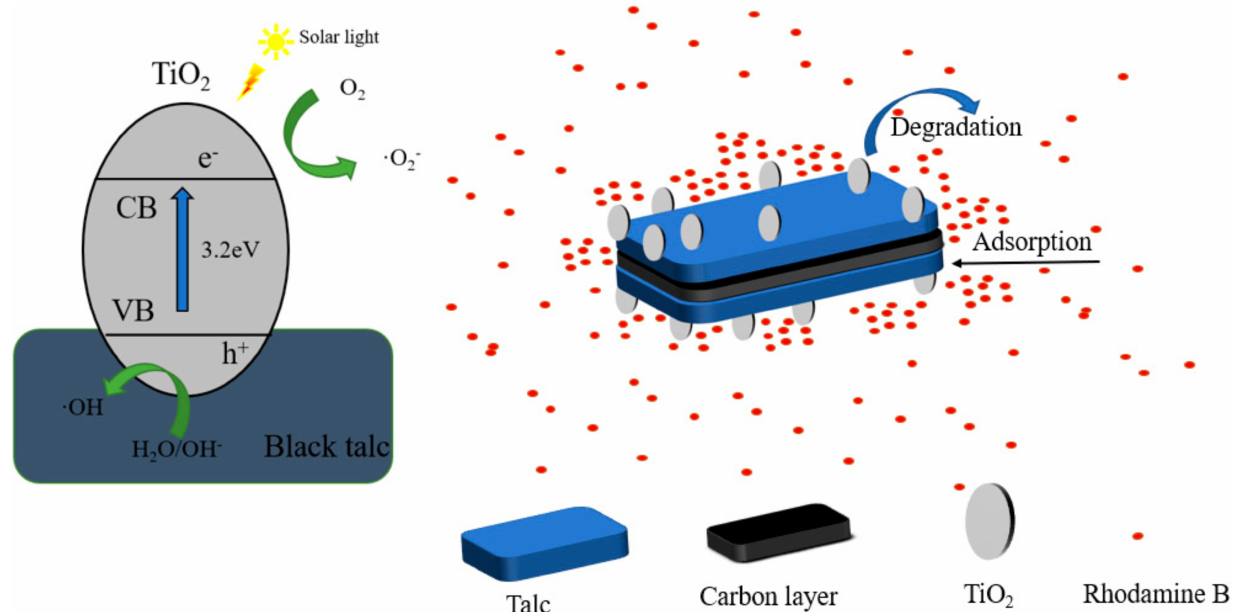
Scheme 1. Schematic diagram of photocatalytic performance enhancement mechanism of BT-T composite